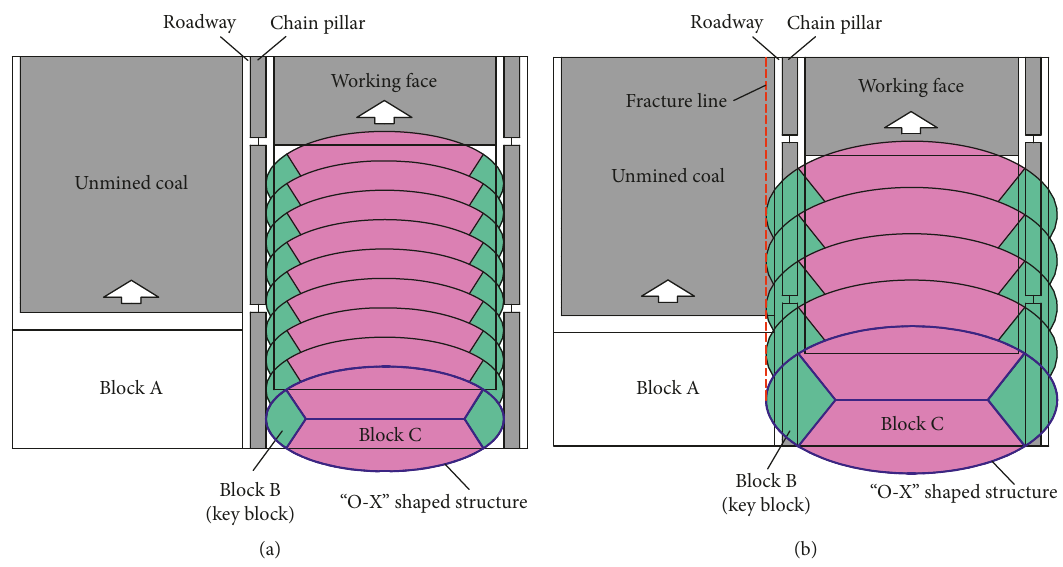
Figure 8: Fracturing structure of roof strata after mining. (a) CRWF. (b)